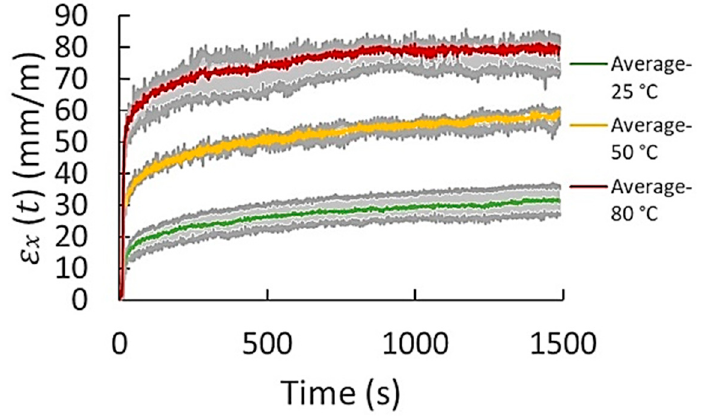
Figure 2. Dispersion of transverse creep data (“x” direction) obtained from three test repeats for FKM at 600 kPa and different temperatures.